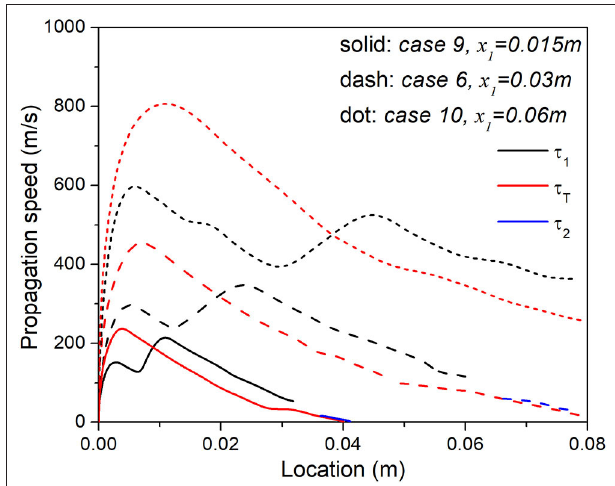
FIGURE 10 | Comparison of the propagation velocity of each heat release peak in Case 6, 9, and 10 with the same equivalence ratio range but different lengths of stratification segment.